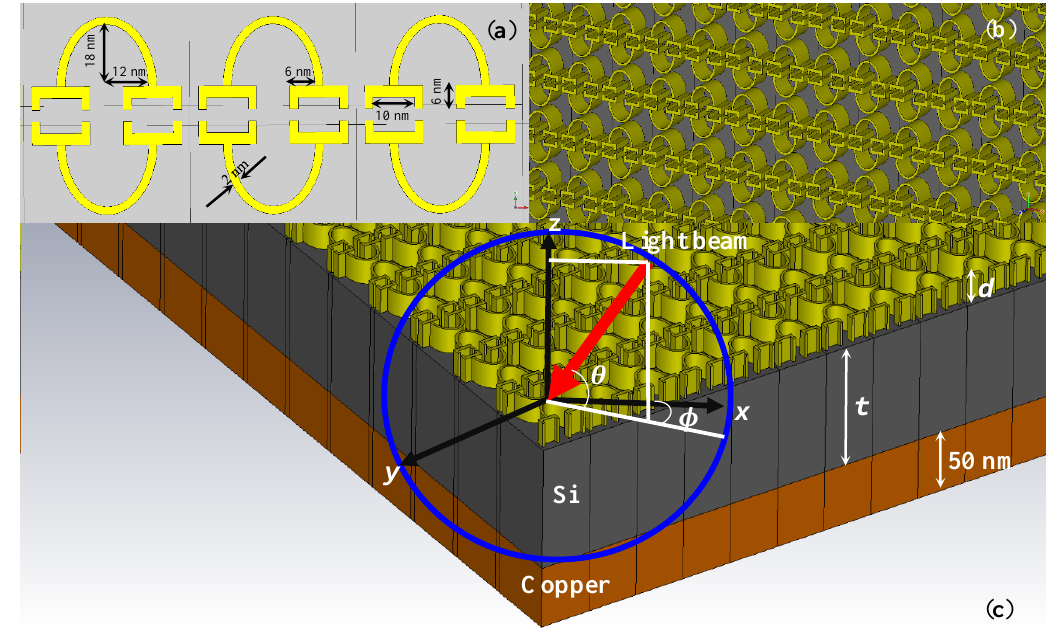
Figure 1. ( a ) Dimensional specifications of the butt-facing U-shaped resonator structure within the unit cell; ( b ) perspective view of the metasurface and ( c ) 3D schematic of multilayer metamaterial prefect absorber (MPA).